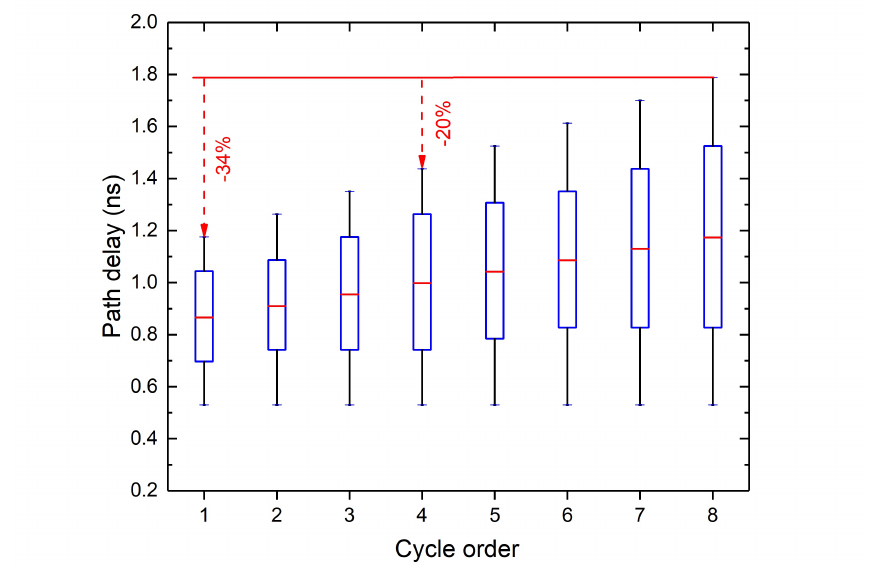
Figure 5. Distribution of path delay in each clock cycle with the proposed dynamic sign extension